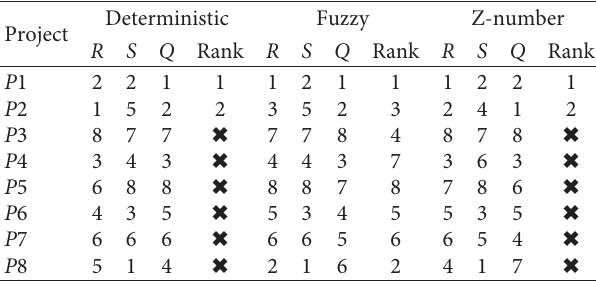
Table 52: Project ranking results using the VIKOR approach under different scenarios (first example: 8